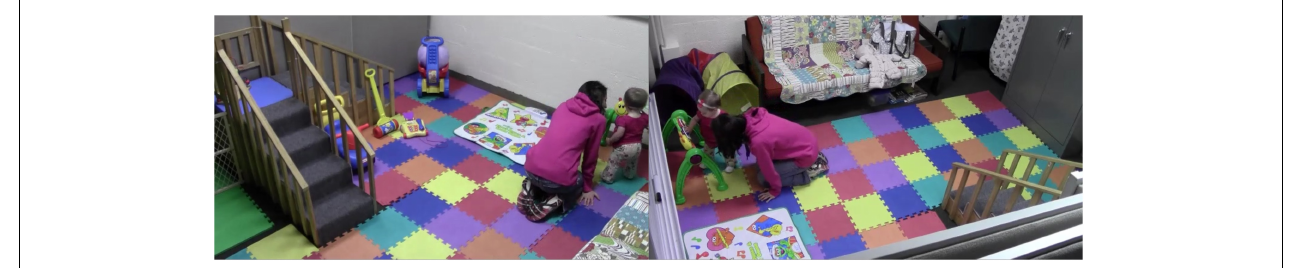
FIGURE 1 | Synchronized camera views of laboratory free play space during a mother and infant free-play